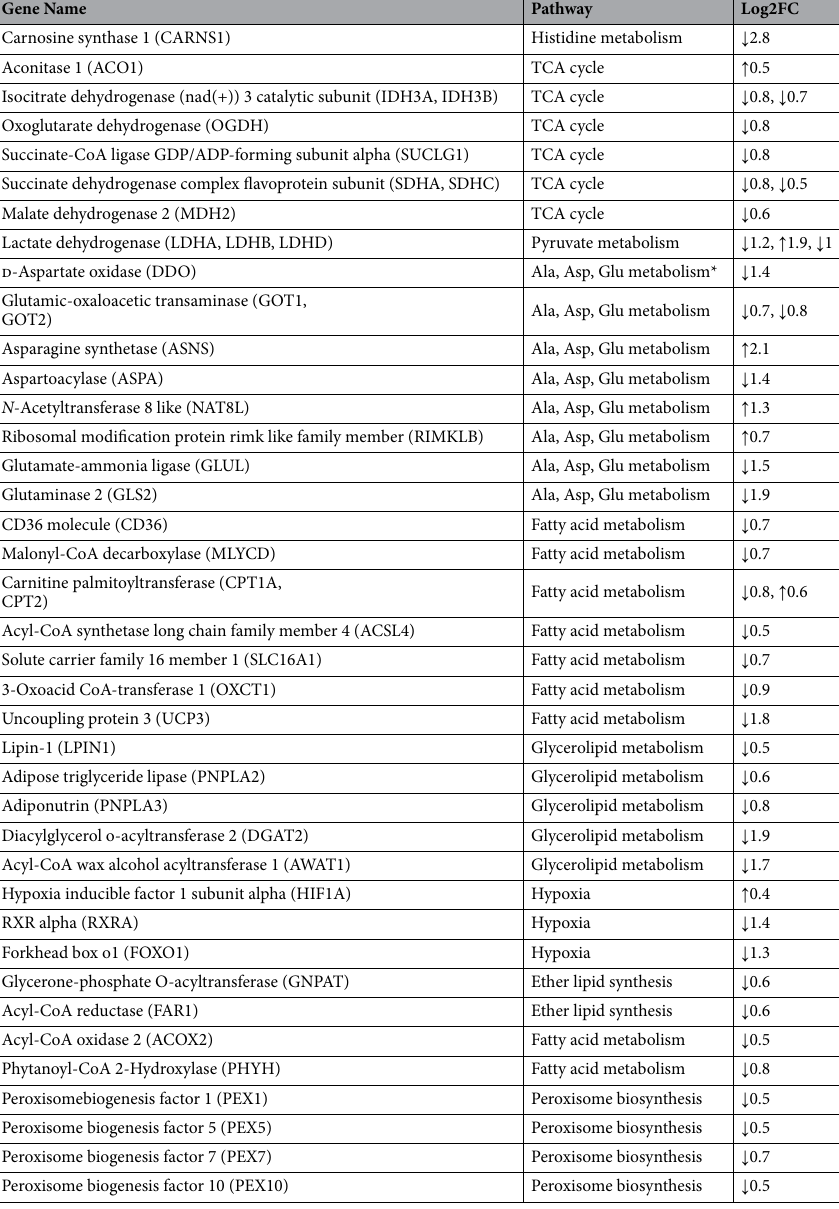
Table 1. Subset of differentially expressed genes in energy metabolism and peroxisome biosynthesis. *Alanine, aspartate and glutamate